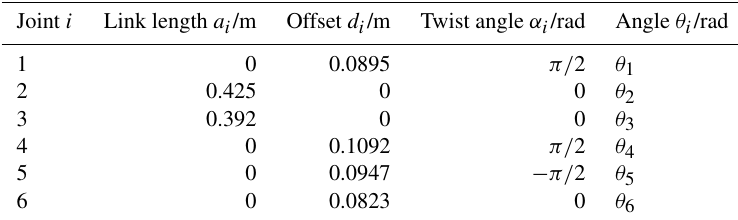
Table 1. D–H parameter table of jean-fabric-grinding robot.